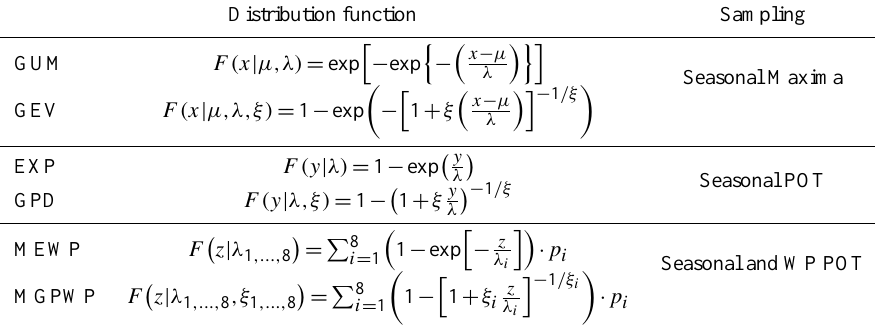
Table 1. Cumulative distribution functions and related sampling method. Label x is used for maxima sampling, y for POT sampling, and z for POT and WP